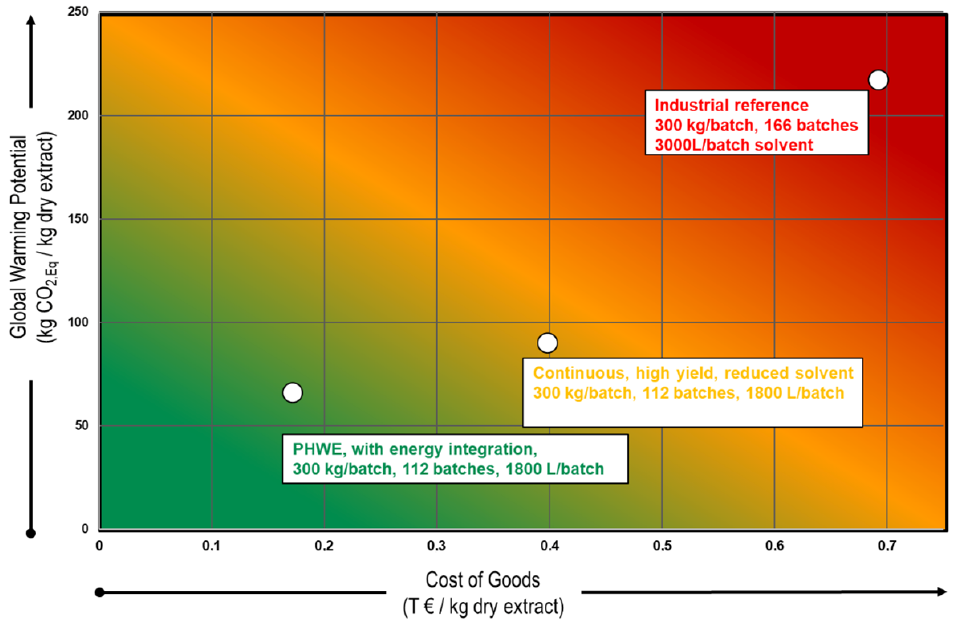
Figure 3. Biologicals GWP (global warming potential) vs. COG (cost of goods) portfolio. mAb: monoclonal antibody.